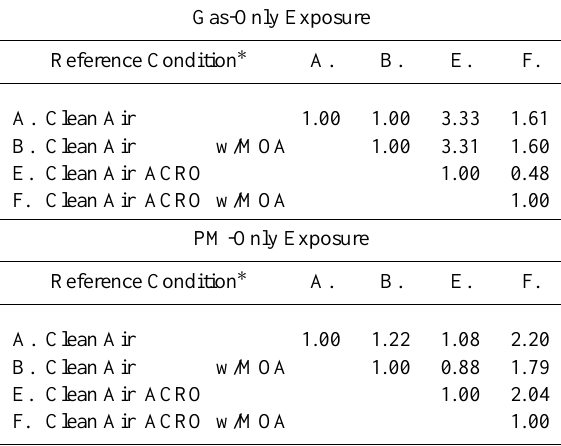
Table 4. Ratios of measured inflammatory responses (IL-8) for in vitro human lung cell exposures to ACRO mixtures, (Table 1 and Fig. 6).